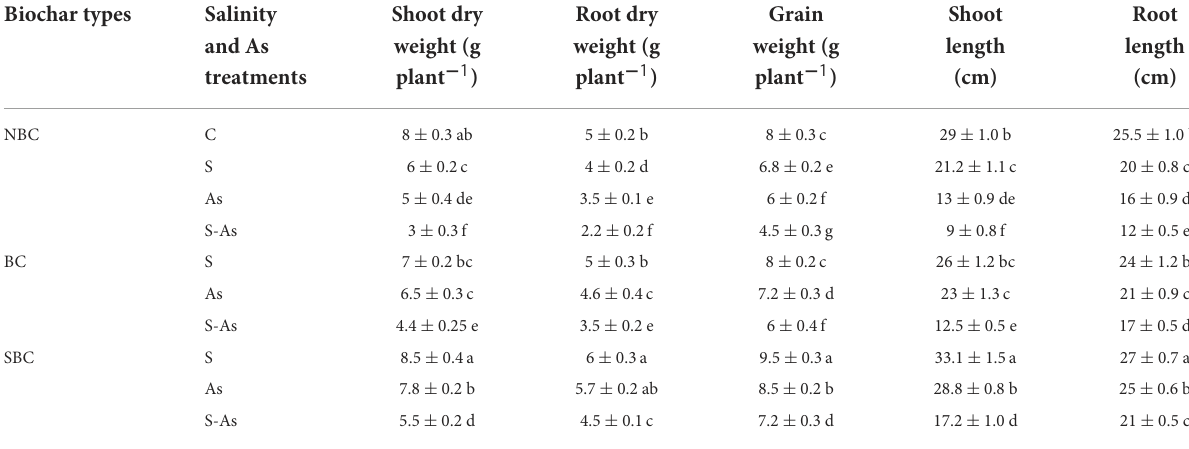
TABLE 1 Effect of salinity, arsenic, and their combination on growth and grain yield of quinoa supplemented with no biochar (NBC), biochar (BC), and silicon-nanoparticles doped biochar (SBC).